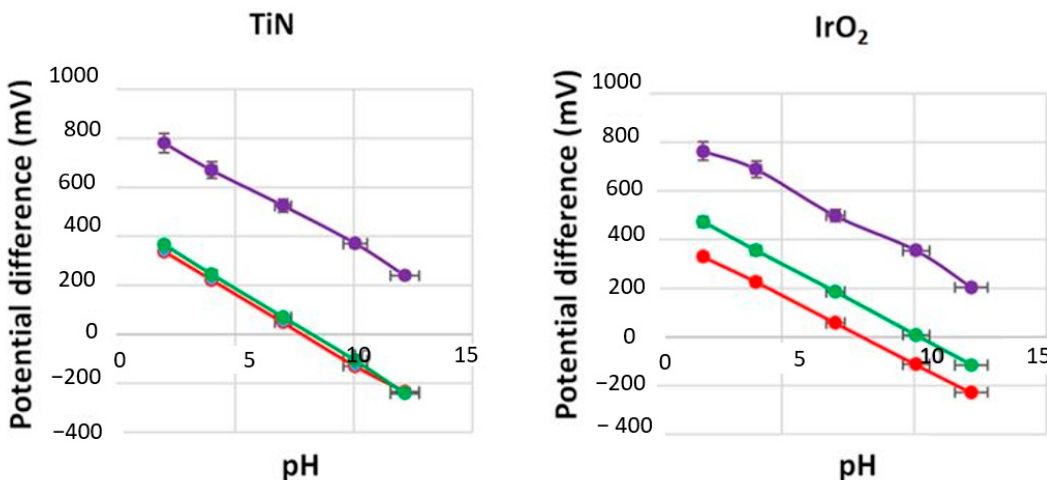
Figure 8. Potential versus time recording for TiN working electrode in pH 7 buffer ( black ), reducing agent ( red ) vs. glass